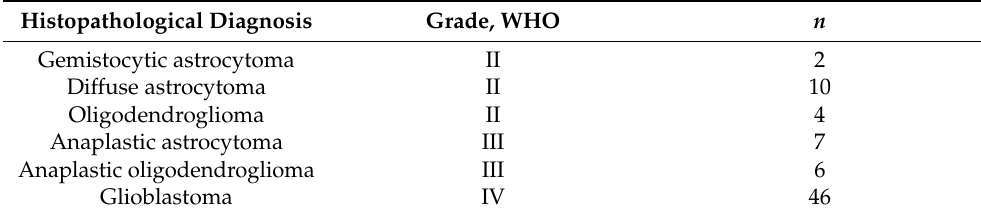
Table 1. Tumor distribution in the study